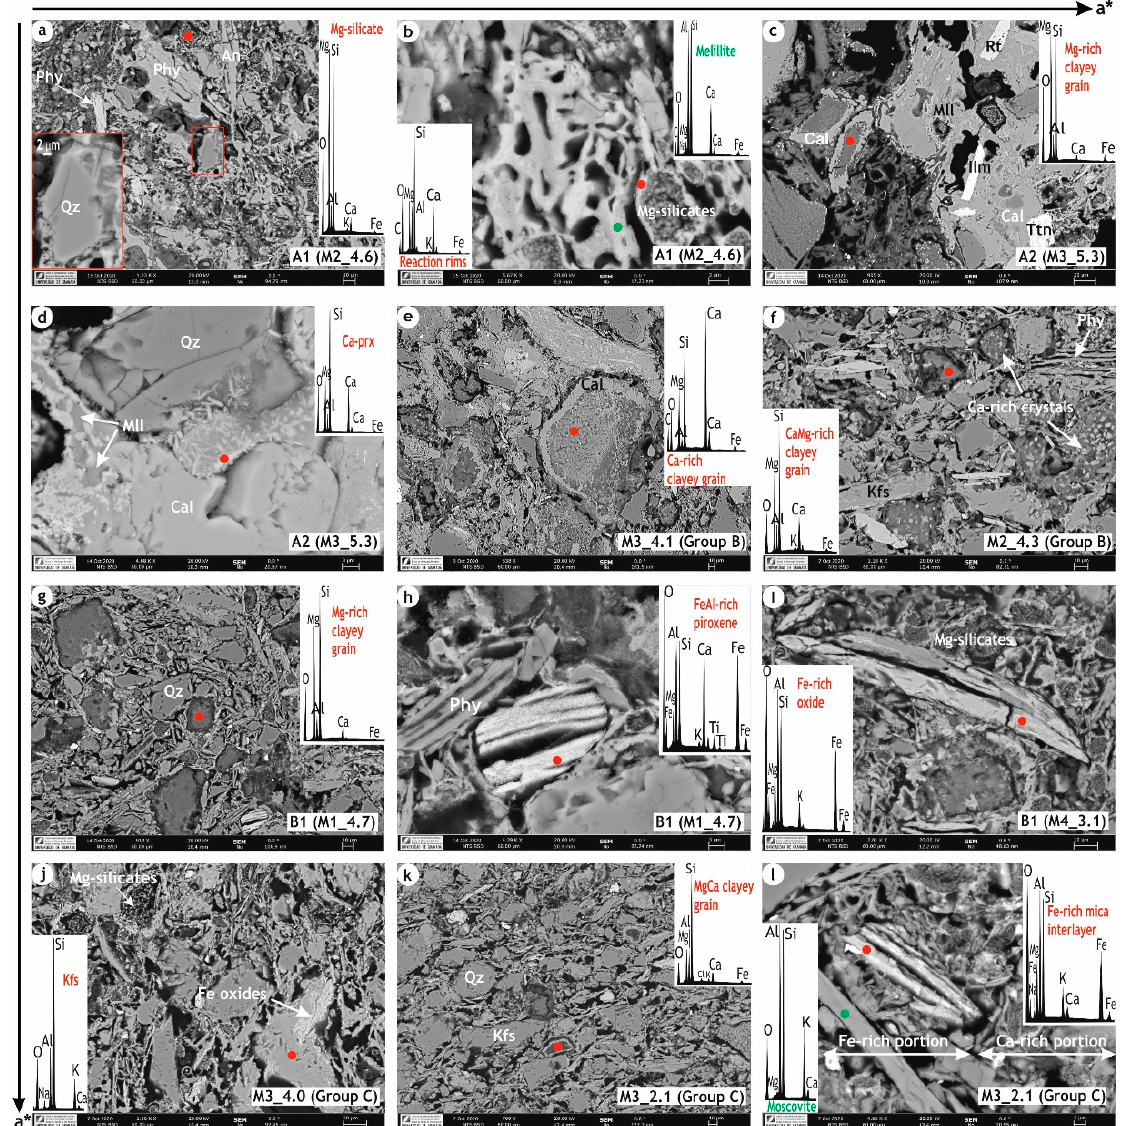
Figure 9. HRSEM-BSE images and EDX spectra performed on the beige hue (A1 and A2 petro-fabrics), pale red (B1 petro-fabric) and dark red bodies. ( a ) General view of the microstructure of petro-fabric A1, with Mg-rich dark particles and phase transformations at quartz grain boundaries; ( b ) Melilite rims around dark particles composed by Mg-rich silicate crystals and partially-melted phyllosilicate in A1 bodies; ( c ) Melilite matrix and secondary calcite extended through petro- fabric A2, secondary calcite likewise filling the shrinkage rims around Mg-rich clayey grains; ( d ) Detail of Ca-pyroxene crystals developed within the melilite-rich matrix; ( e ) High Ca-rich clayey grains with shrinkage rims cemented by sec- ondary calcite; ( f ) Preferred orientation of elongated inclusions and Ca-rich crystals within carbonate rich clayey frag- ments; ( g ) Microstructure with scarce melting evidence of petro-fabric B1 where Mg-rich clayey inclusions slightly altered at boundaries are noted; ( h ) Detail of phyllosilicate with marked exfoliation along (001) planes and possible fassaite-type pyroxene; ( i ) Fe-rich crystals (possibly hematite) growth along illite flake; ( j ) General view of the microstructure, Fe-oxides also growth within K-feldspar grains; ( k ) Very low vitrified matrix in which pristine phyllosilicates—partially oriented— are still recognizable and angular shapes of silica inclusions are still remained, and ( l ) Pristine illite/muscovite and Ca-rich mixed clays. Legend: phyllosilicates (Phy), quartz (Qz), An (anorthite), melilite (Mll), rutile (Rt), ilmenite (Ilm), titanite (Ttn), calcite (Cal) and k-feldspar (Kfs). After Whitney and Evans [75].